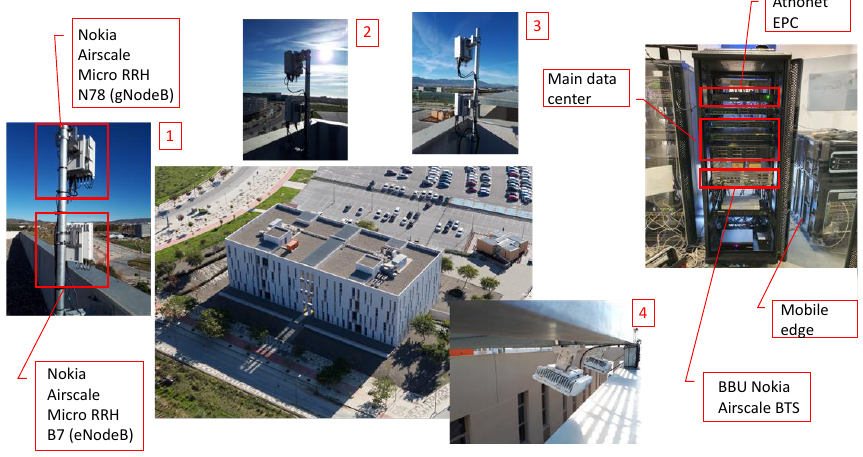
Figure 3. 5G NR NSA deployment at UMA campus. The operation band is also reported for the Radio Remote Heads (RRHs) forming gNBs/eNBs, numbered from (1) to